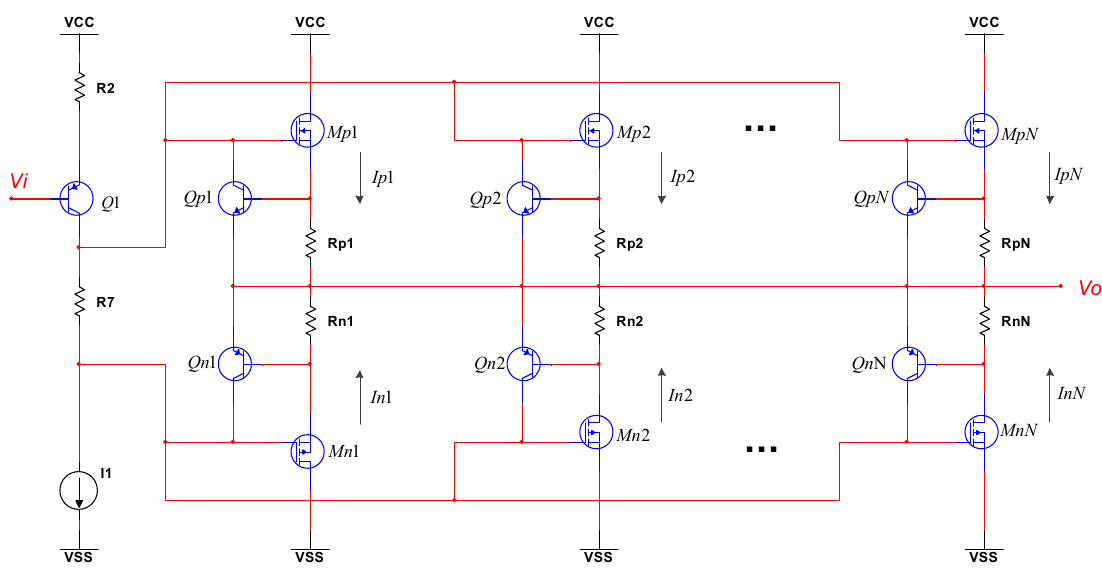
Figure 4. The power-amplifier circuit with multi-level parallel connection.